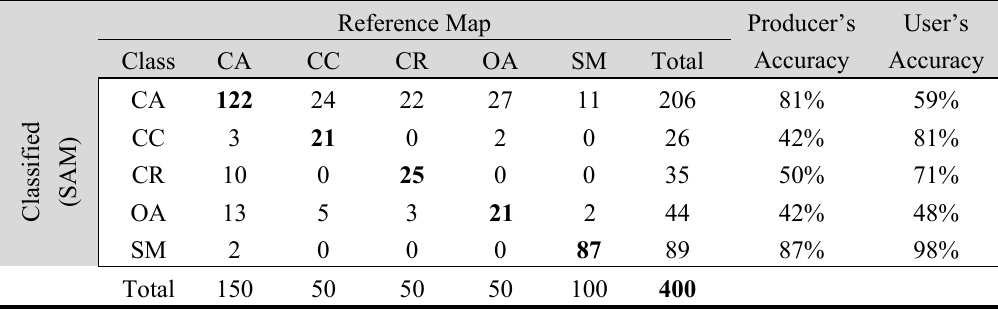
Table 3. Error matrix for the SAM classified map versus reference map.